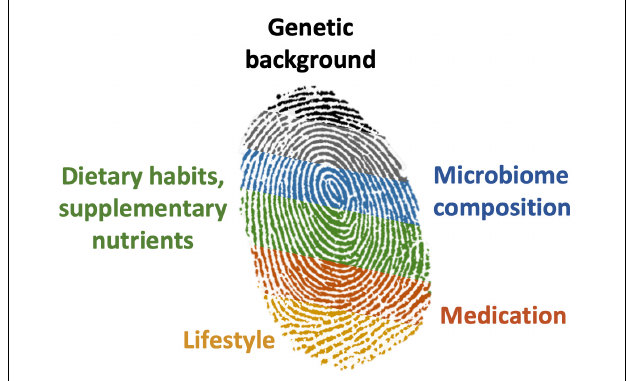
FIGURE 1 | An individual’s healthspan is determined by inter-organ crosstalk of genetic, and modifiable environmental and lifestyle events that may be illustrated as a characteristic fingerprint, which influences body physiology, metabolism, and